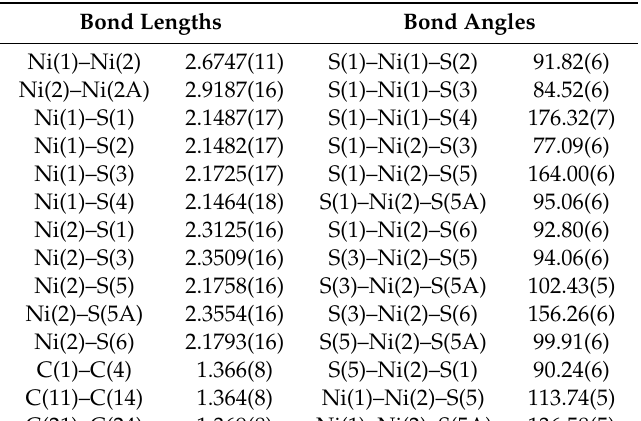
Table 1. Selected bond lengths [Å] and angles [ o ] for 4·2CH 3 CN·2Et 2 O (label extension A refers to symmetry (1 − x, 1 − y, 1 − z) generated atoms; all data are presented in the Supplementary Material, Table S2).